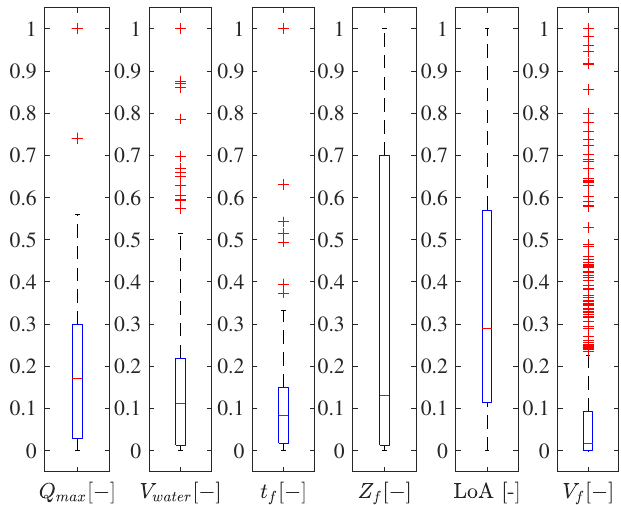
Figure 6. Analysis of the five input parameters and the output parameter. During the training step, the ANN learns the relationship between the input and target data. Before training, the prepared data are first separated randomly into three subsets—training (70%), testing (15%), and validation (15%)—to avoid overfitting and to obtain a generally applicable ANN. Moreover, the number of neurons was tested iteratively, from 2 to 11, using Equation (2). It is important to mention that the initial weights can